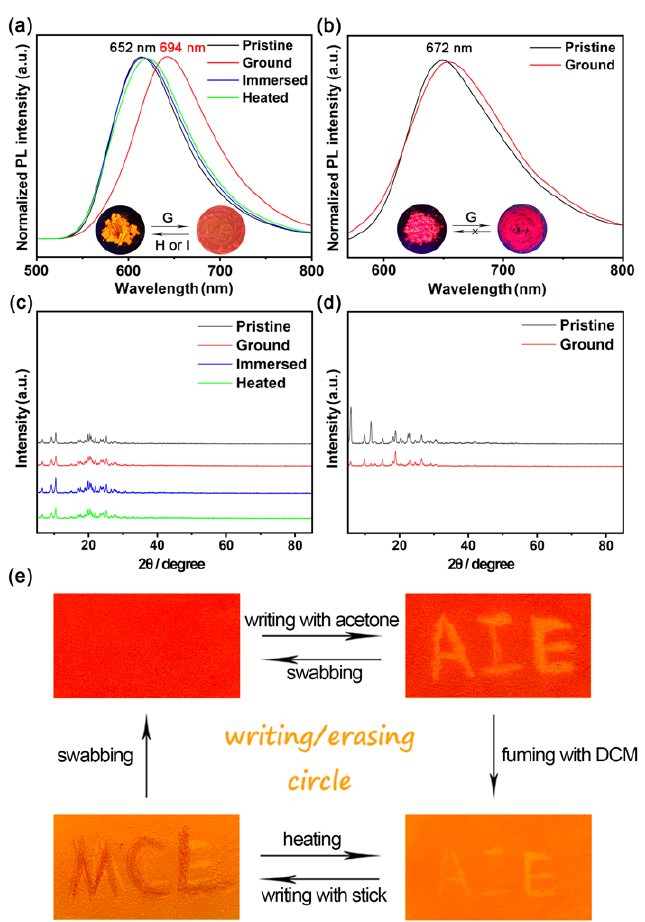
Figure 4. ( a ) Emission spectra of a pristine, ground sample, an immersed sample, and a heated sam- ple of PDB2. ( b ) Emission spectra of a pristine, ground sample of PDB4. ( c , d ) Powder X-ray diffraction patterns of PDB2 and PDB4 in different states. ( e ) Photos of PDB2 in the writing/erasing cycle under UV light ( λ ex = 365 nm). Inset: Photos upon irradiation with 365 nm UV light of PDB2 and PDB4 in different states.